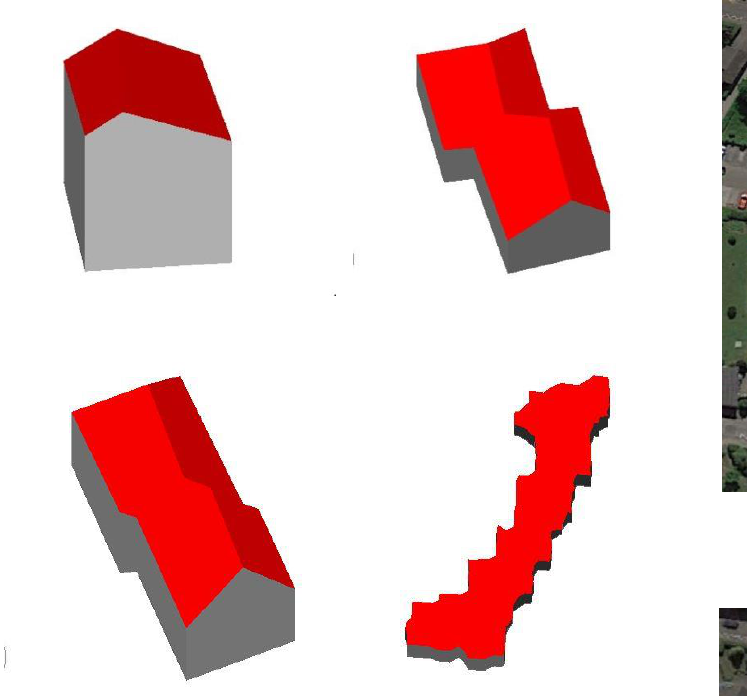
Figure 7- LoD2 CityGML model created by citygml4j